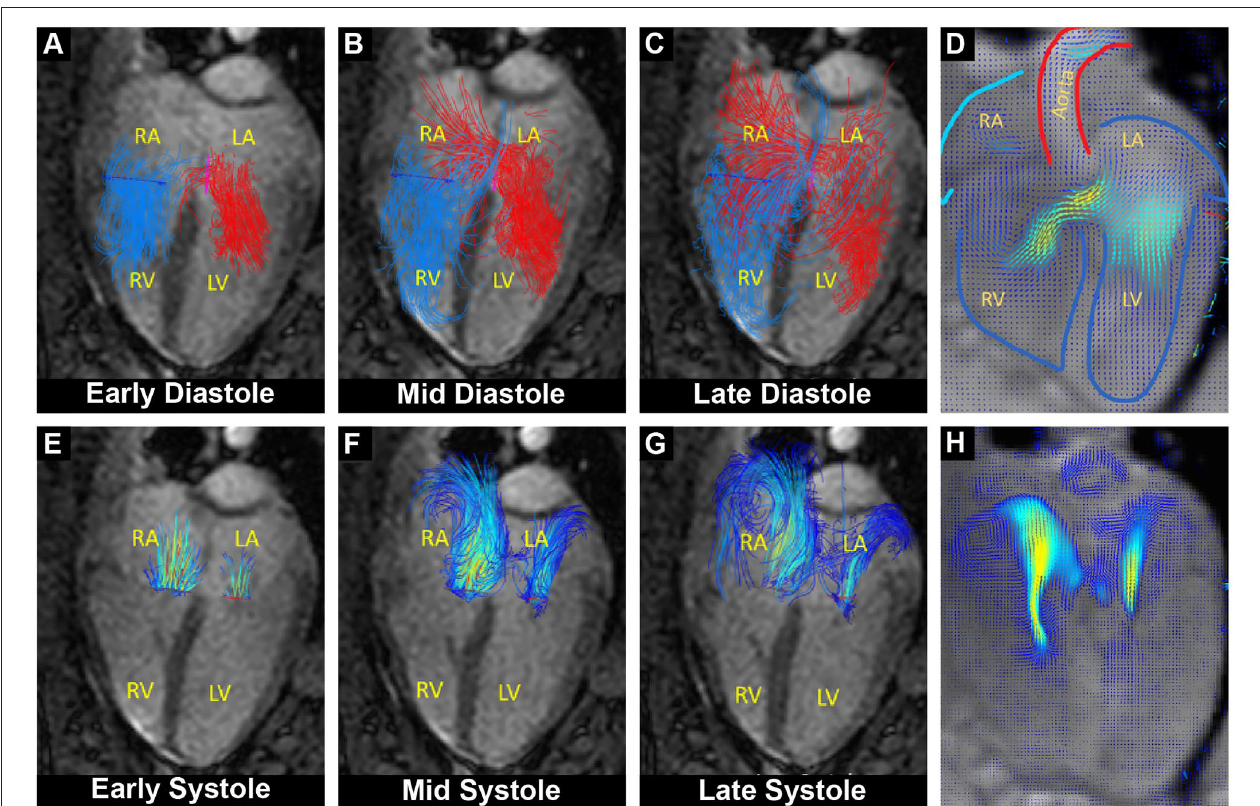
FIGURE 2 | Overlay of cardiac functional MRI and pathline visualization of blood flow during the cardiac cycle. RA, right atrium; LA, left atrium; RV, right ventricle; LV, left ventricle. (A–C) Pathline visualization of blood flow originating from the left (red) and from the right (blue) atrium, showing left-to-right flow across the atrial septum during diastole (L-R shunt). (D) Velocity field visualization focused on the diastolic shunt across the atrial septum. (E–G) Pathline visualization of regurgitant blood flow through the closed mitral and tricuspid valve during systole. (H) Velocity field visualization focused on the systolic mitral and tricuspid regurgitant